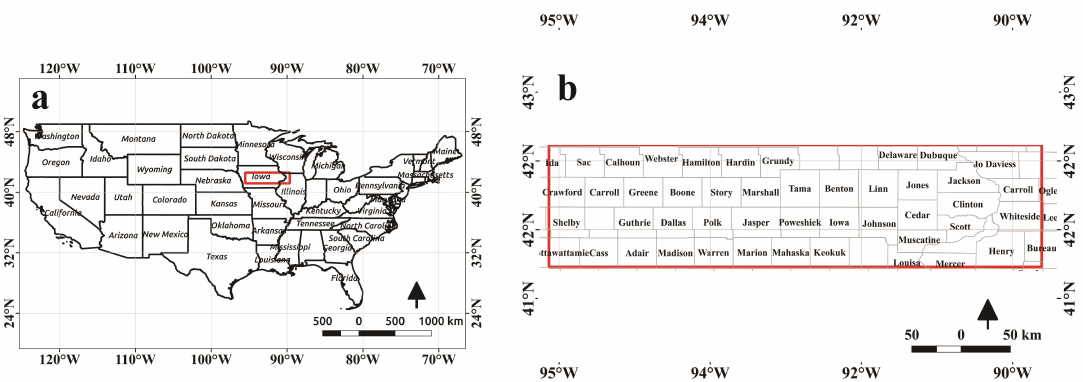
Figure 1. Study area covering ( a ) the region a ff ected by the 2020 Derecho lodging disaster in the states of Iowa and Illinois as shown by the red outline and ( b ) the 52 counties in the a ff ected